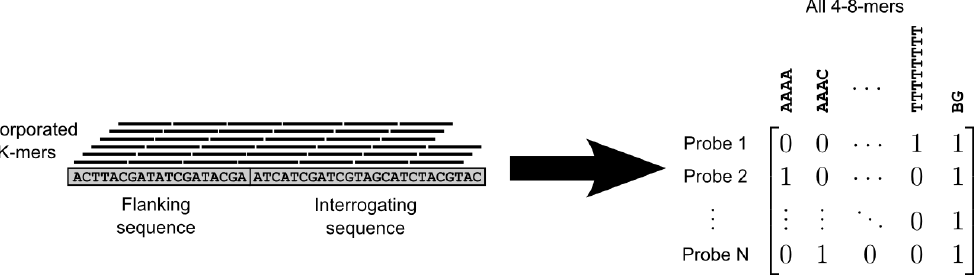
Figure 2. Construction of a PBM array design matrix. Both the flanking and interrogating sequences are considered when building the matrix. A column for a constant background component is also included in the matrix.